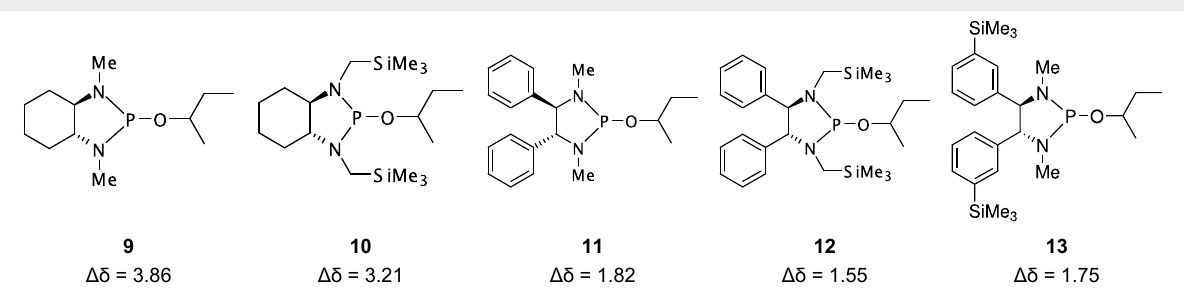
Table 1: 31 P chemical shift differences Δδ (ppm) of some butan-2-ol P-(III) derivatives (in CDCl 3